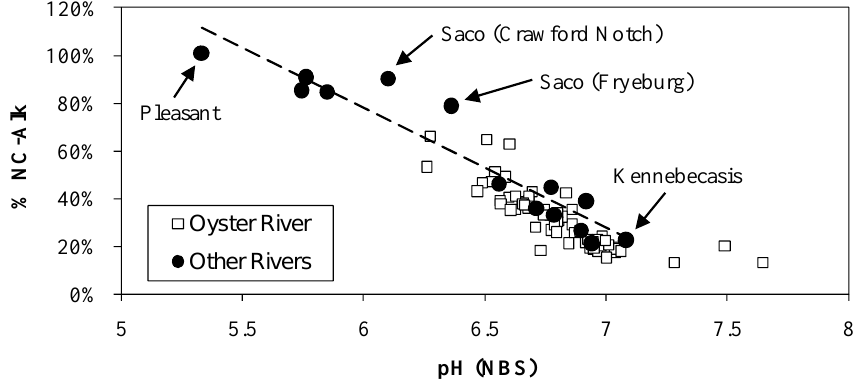
Fig. 4. Relationship between pH (measured in the lab) and the calculated percentage of NC-Alk in the Oyster River and in the sampled rivers in northern New England and Canada (Other Rivers, Table 1). The dotted line shows the linear regression of the Other Rivers, having the equation %NC-Alk= − 0.5 · pH+379. Table 3. Comparison of pH, TAlk and DOC measurements from this study to data obtained from the